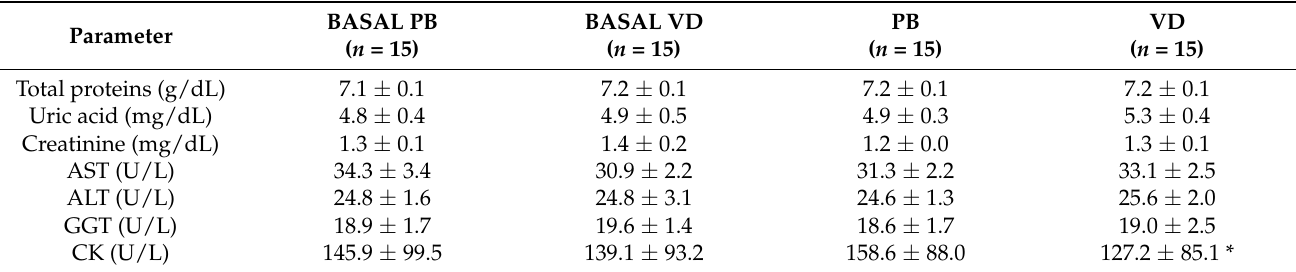
Table 3. Circulating metabolites and tissue